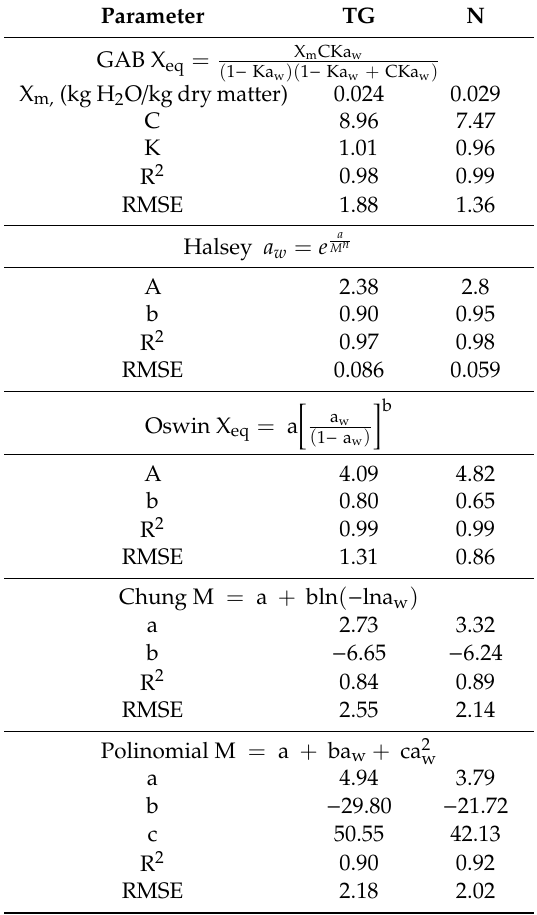
Figure 4. Water sorption isotherms (20 °C) of the powders (N and TG). GAB, Halsey, Oswin, Chung and polynomial models were fitted to the experimental sorption data. The fitting parameters were determined by a non-linear regression analysis and are presented in Table 2. Table 2. Estimated values of the parameters and statistical coefficients for the mathematical models of GAB, Halsey, Chung, Polinomial, and Oswin.